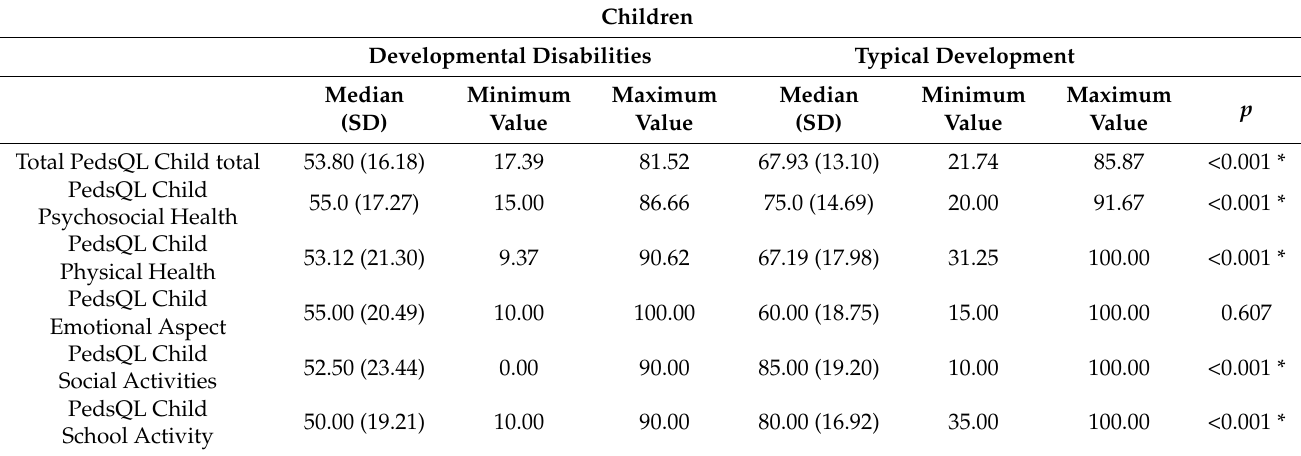
Table 2. Comparison between the children with DD and TD for the children’s QoL